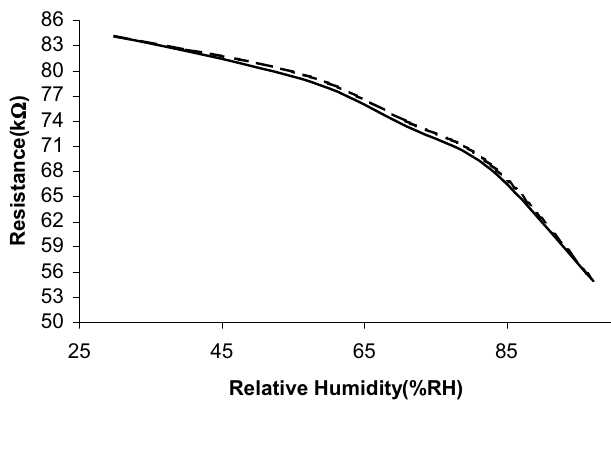
Figure 8. Hysteresis of Sample